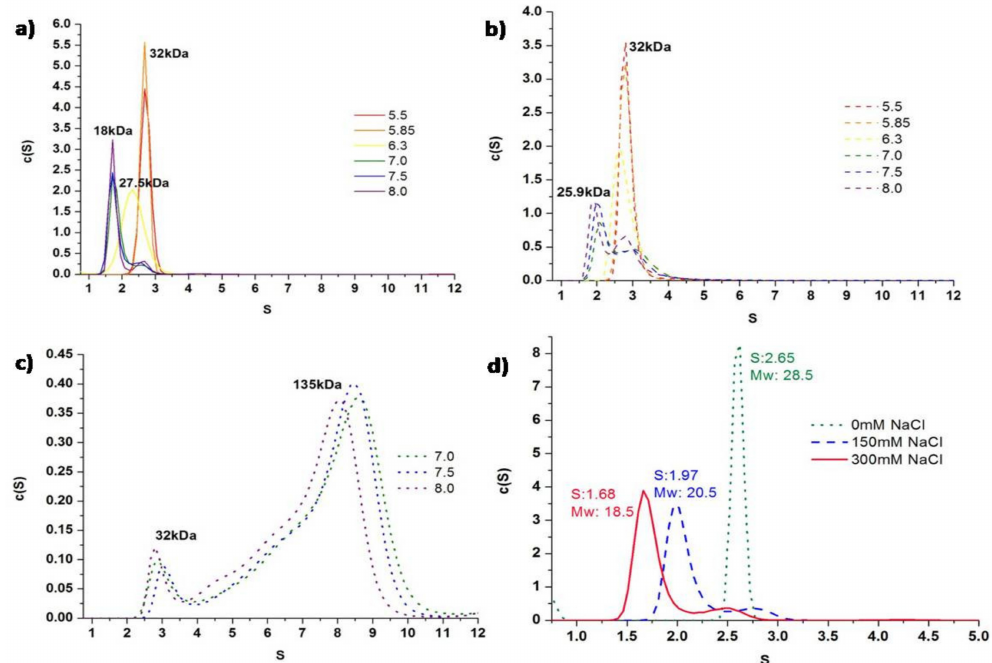
Figure 3. Sedimentation profiles of AcSpN and MaSpN. Overlay of sedimentation profiles of AcSpN at varying pH in the presence of 300 mM NaCl ( a ), 150 mM NaCl ( b ), and 0 mM NaCl ( c ). Overlay of sedimentation profiles of MaSpN at pH 7.0 and in the presence of varying NaCl concentrations ( d